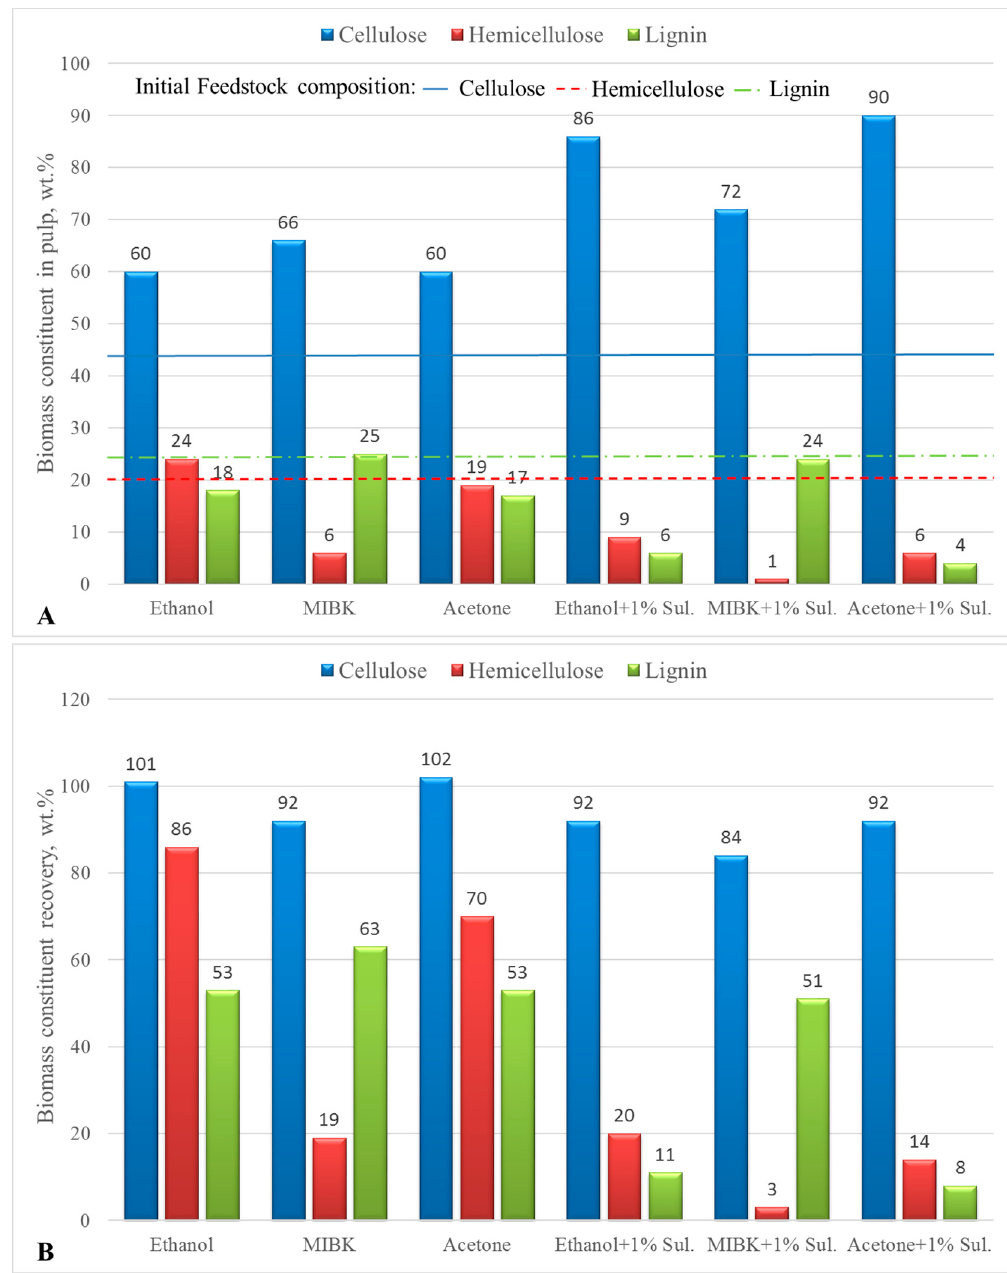
Figure 1. Pulp compositions ( A ) and biomass constituents’ recoveries ( B ) in solid pulps in batch autoclave runs at 175 °C, 1 h reaction time, LSR = 10, effect of organic solvents without and with use of 1 wt.% H 2 SO 4 , data labels have been rounded for clarity of presentation.